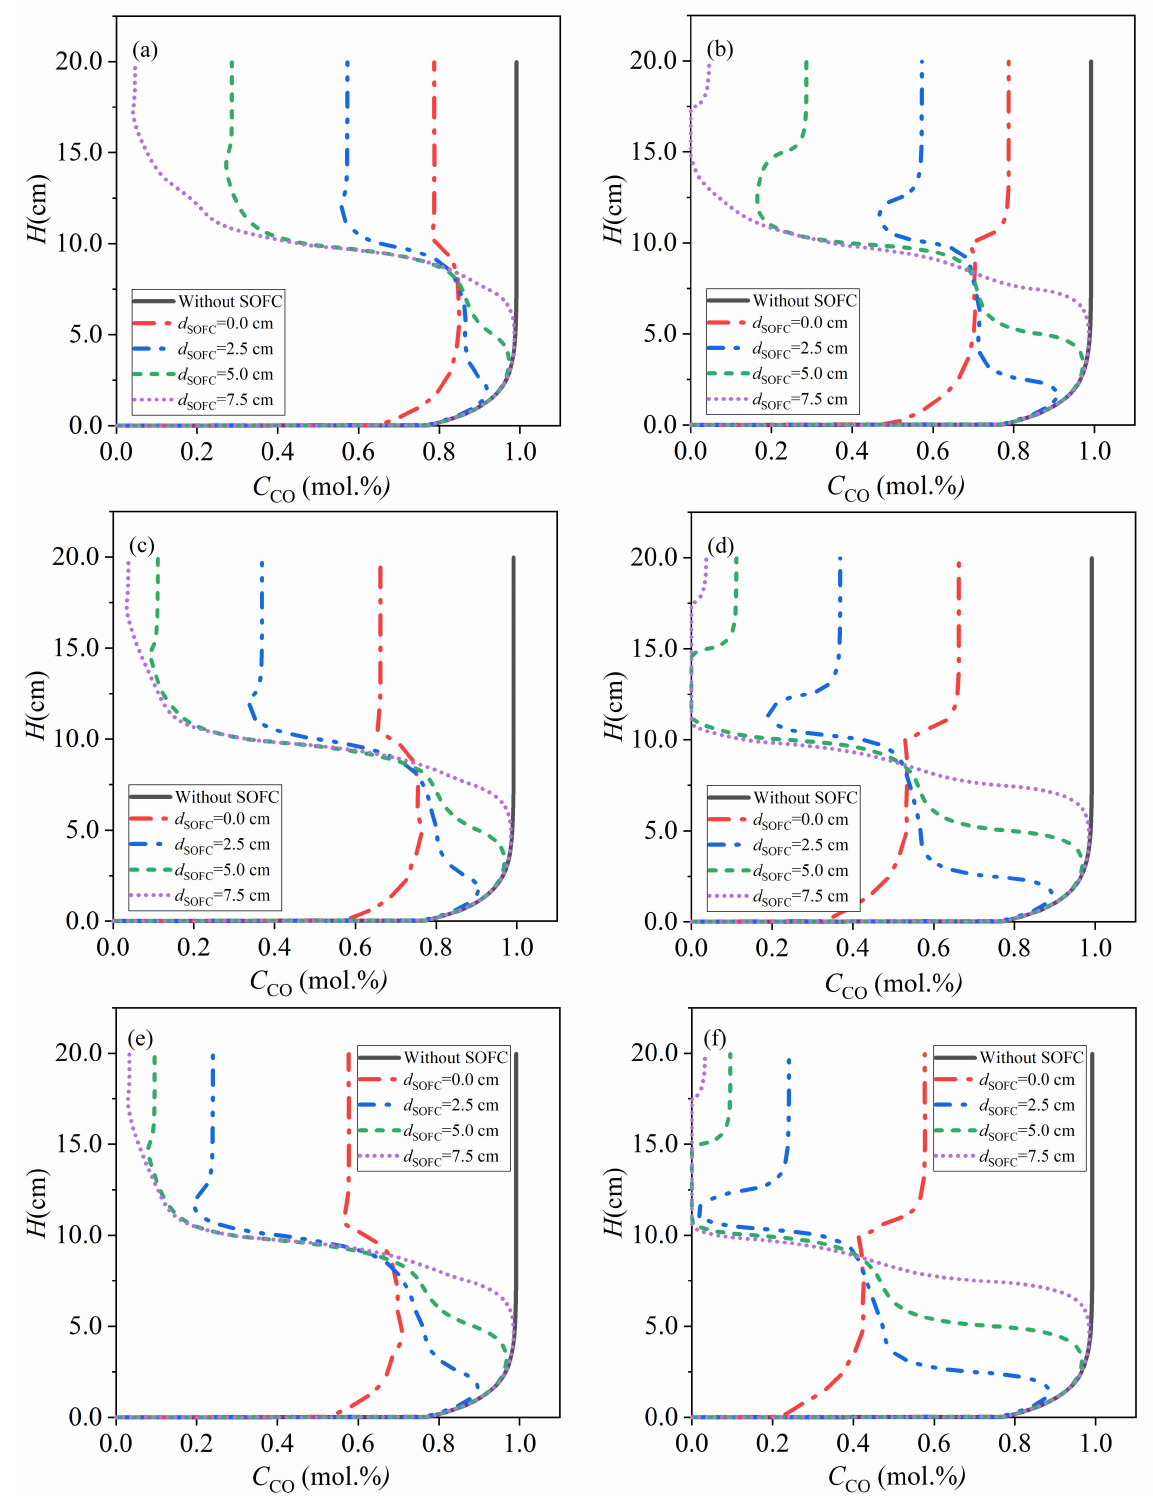
Figure 9. Averaged CO molar fractions ( a , c , e ) and CO molar fraction near side walls ( b , d , f ) along channel for fixed bed gasifiers coupled with SOFC with A s = 7.2 × 10 − 5 mol/m 2 , v CO ( e , f ) 10,000 A/m 2